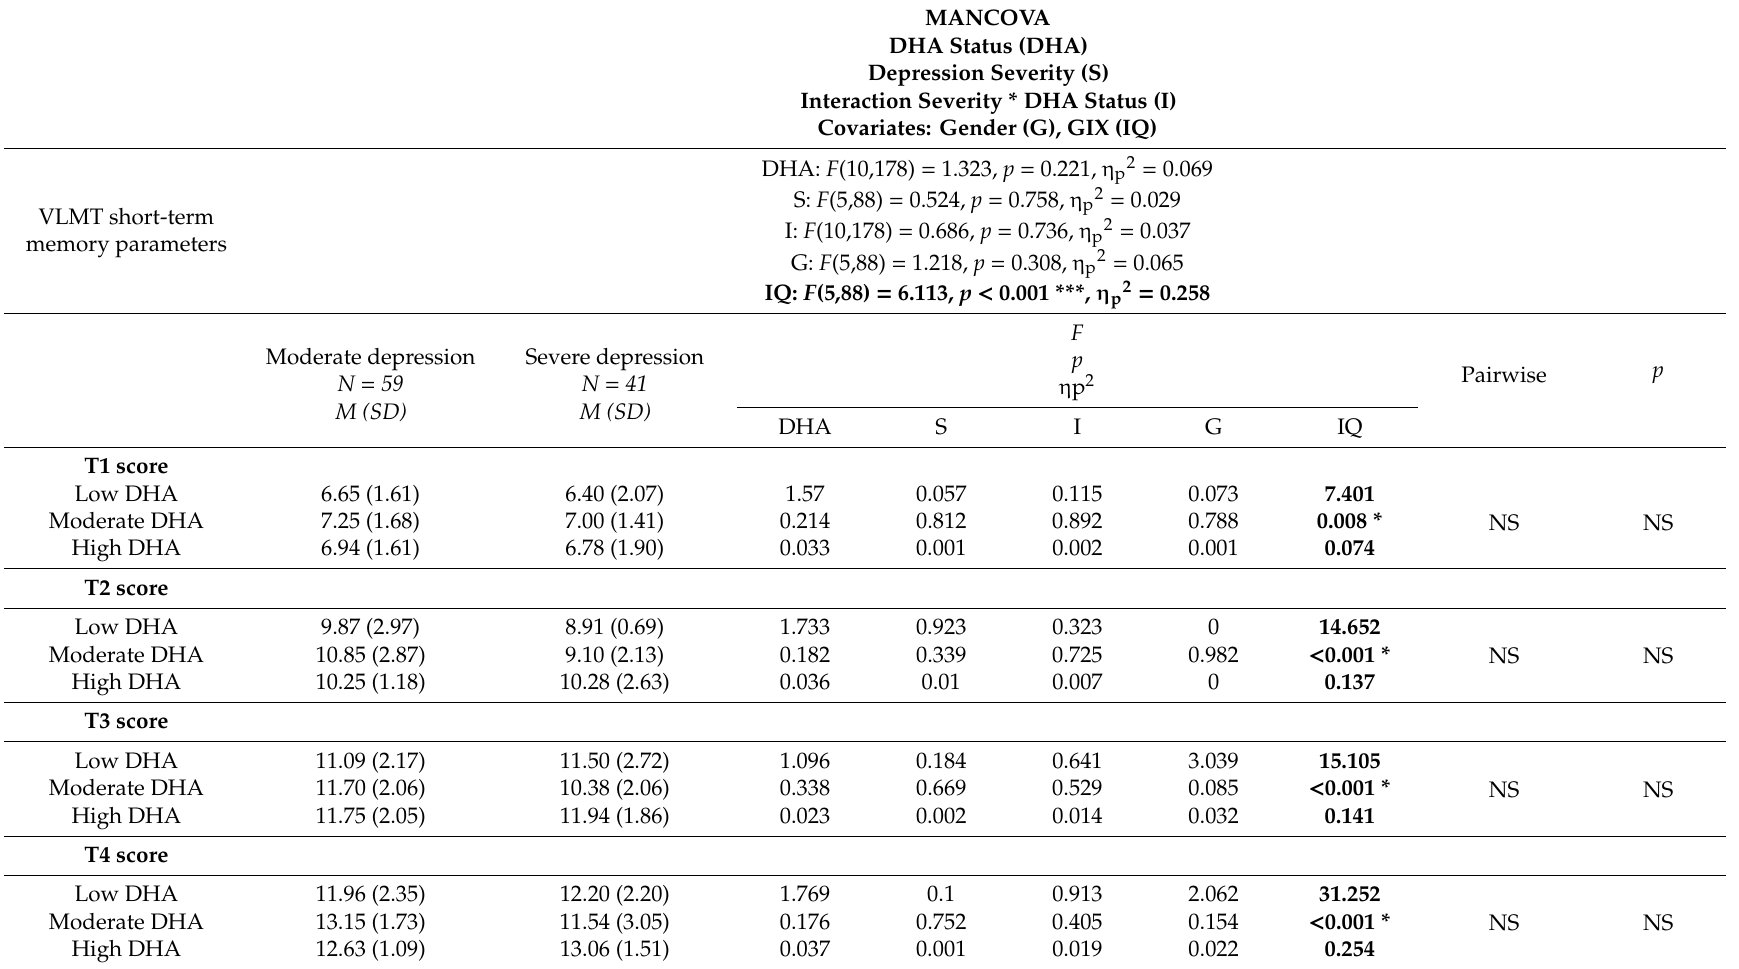
Table 4. MANCOVA and ANCOVA results for the VLMT and digit span